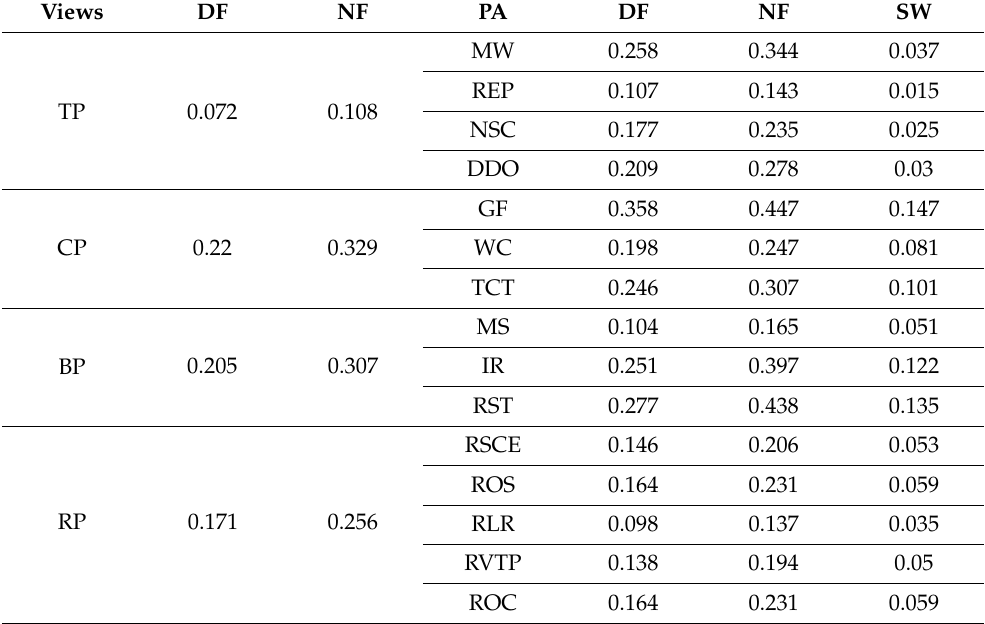
Table 12. The results of defuzzification, normalization and synthesis weights in views and parameters. Views